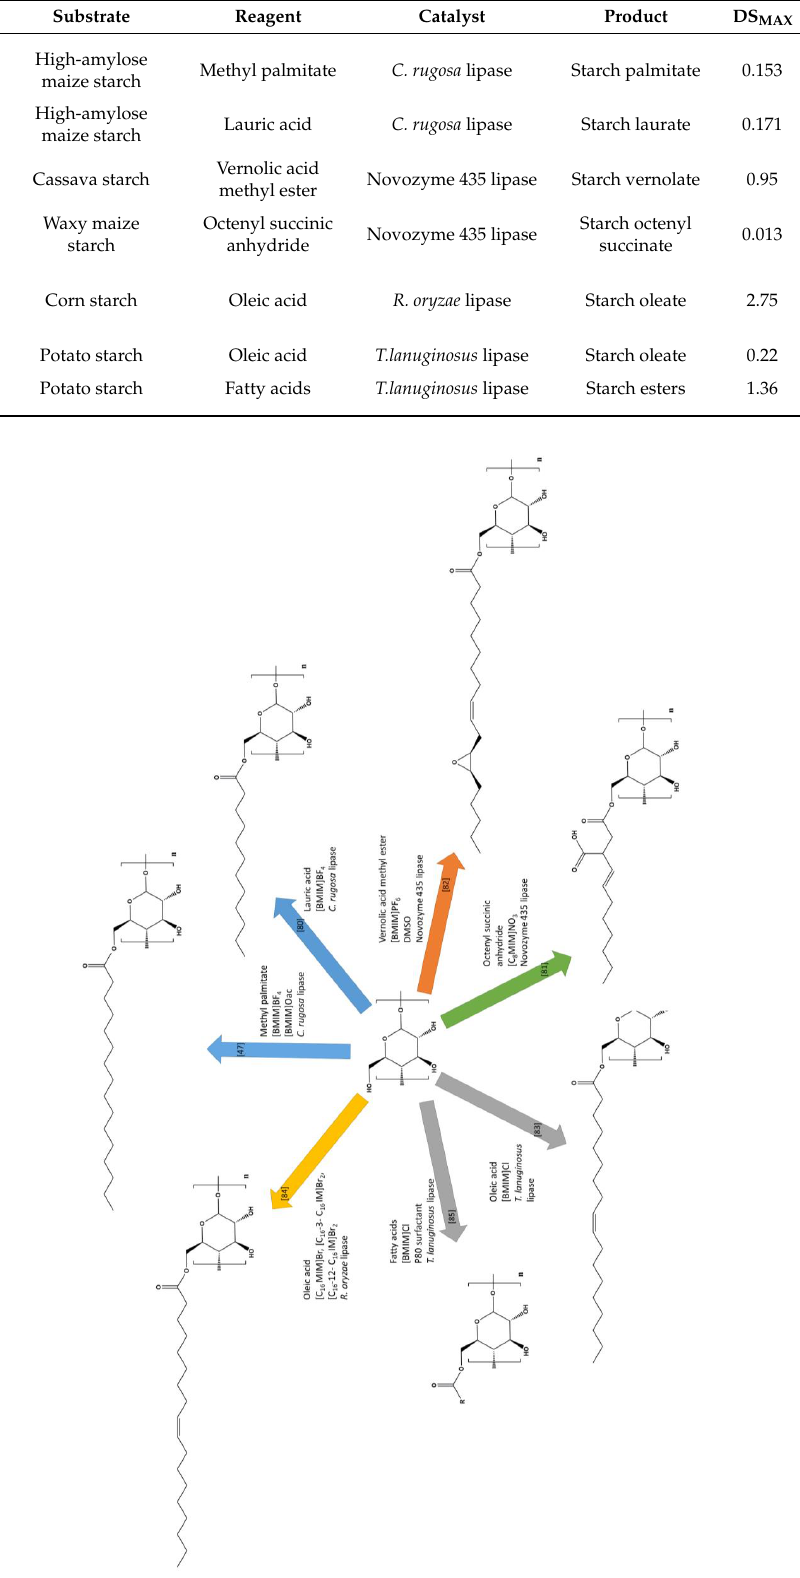
Figure 7. Biocatalyzed esterification of various types of starch ( → high-amylose maize starch, → cassava starch, → waxy maize starch, → potato starch, → corn starch) in ionic liquids.